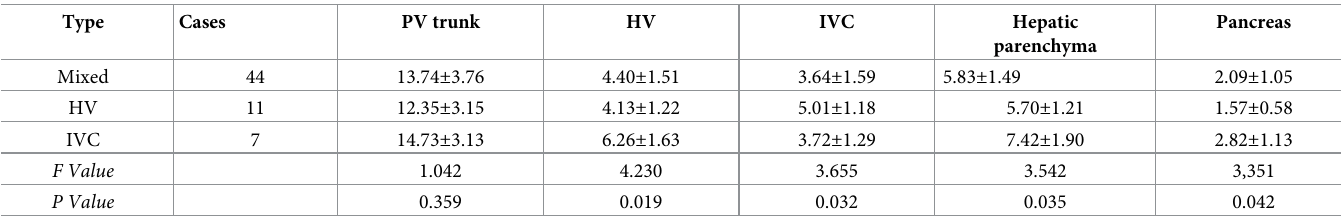
Diagnostic confidence subjective score for different types of BCS Diagnostic confidence was highest for the IVC type and lowest for the HV type. The difference was statistically significant ( p = 0.043), (Table 2). Table 1. Comparison of CNR values for the PV trunk, HV, IVC, hepatic parenchyma and pancreas in different BCS types (mean ± SD).